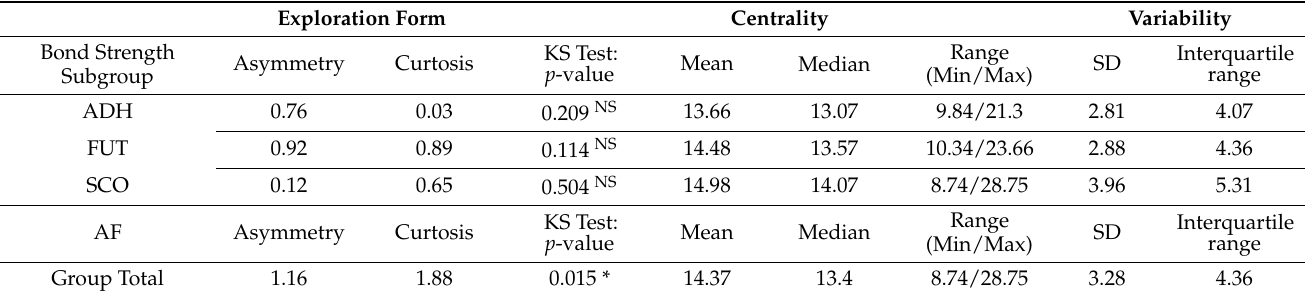
Table 2. Bond strength descriptive analysis. Variable adhesion strength depending on the type of adhesive ( n = 50) and in the total sample ( n = 150).